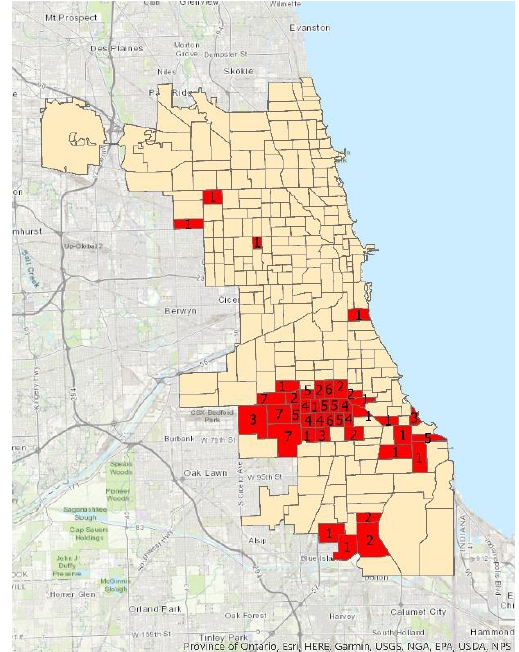
Figure 13. High value clusters by weekday at police beat